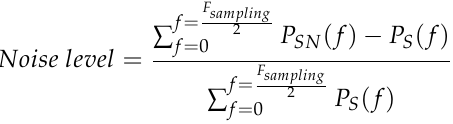
Table 3. List of activities that introduce noise in the heart sound signal and the corresponding ref- erence activities that represent the signal.